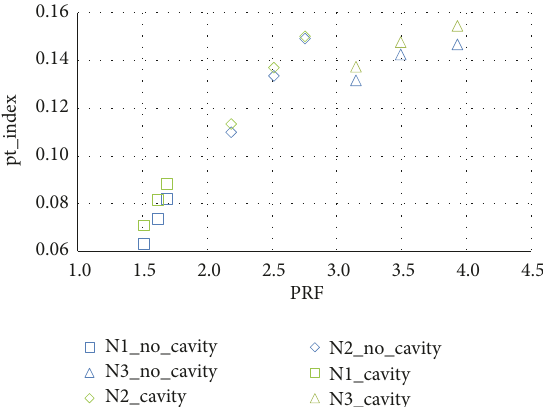
Figure 24: pt index vs PRF, partial hub admission.